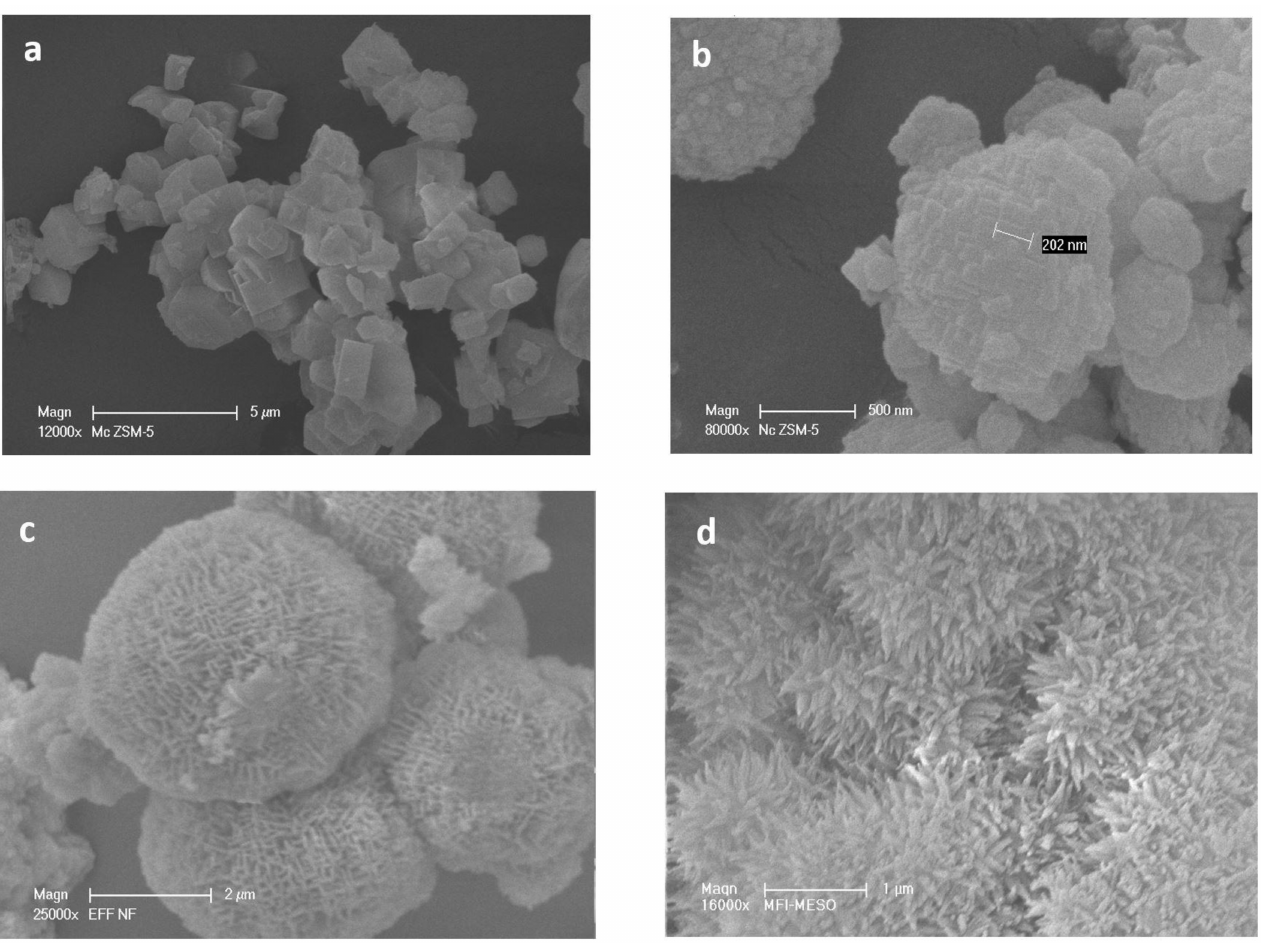
Figure 2. Scanning electronic microscopy (SEM) images of ( a ) MC-HZSM5, ( b ) NC-HZSM5, ( c ) NSh-HZSM5, and ( d ) NS-HZSM5.